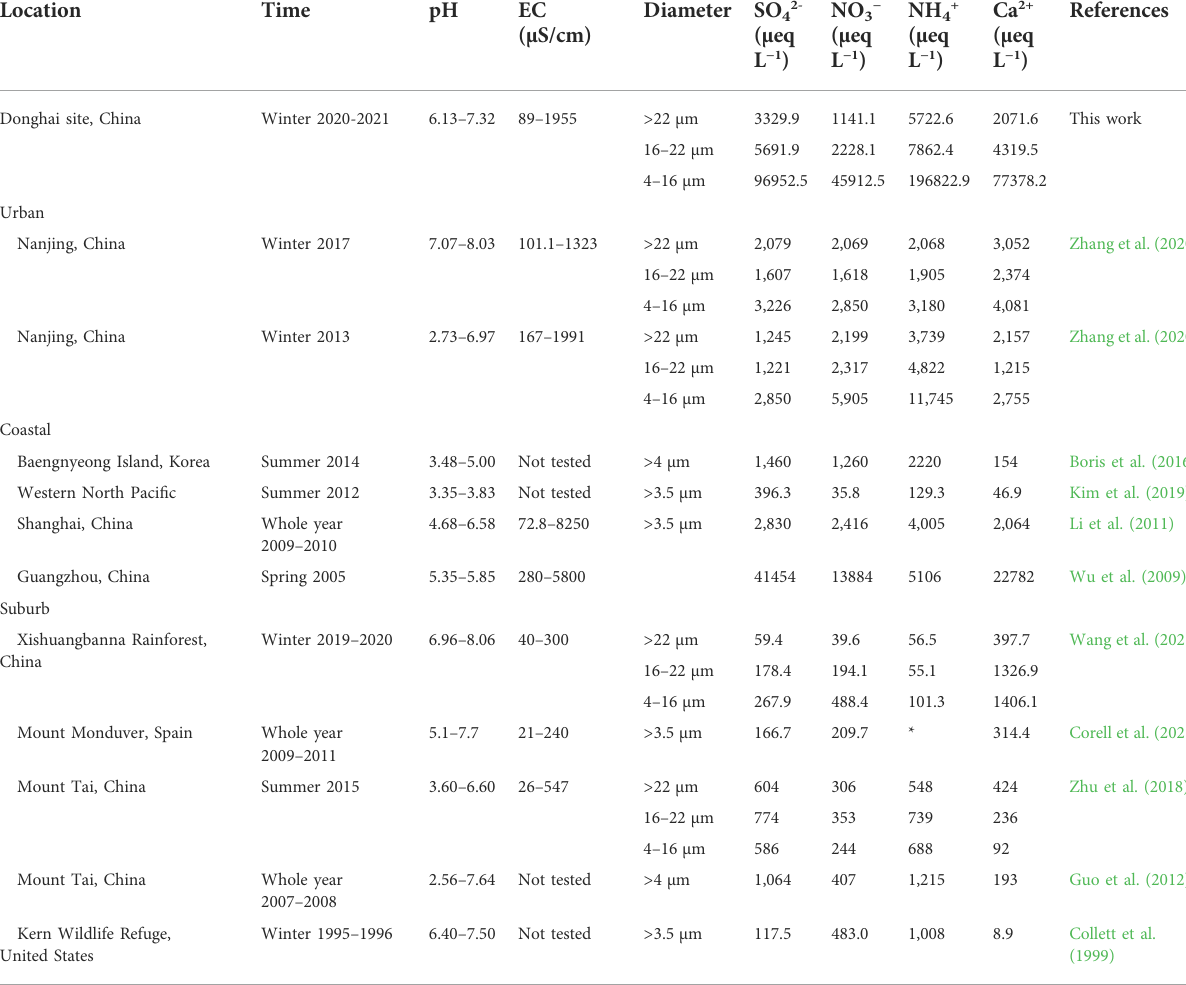
TABLE 1 Comparison of pH, electrical conductivity (EC), and main ion concentrations of fog water measured in different regions.